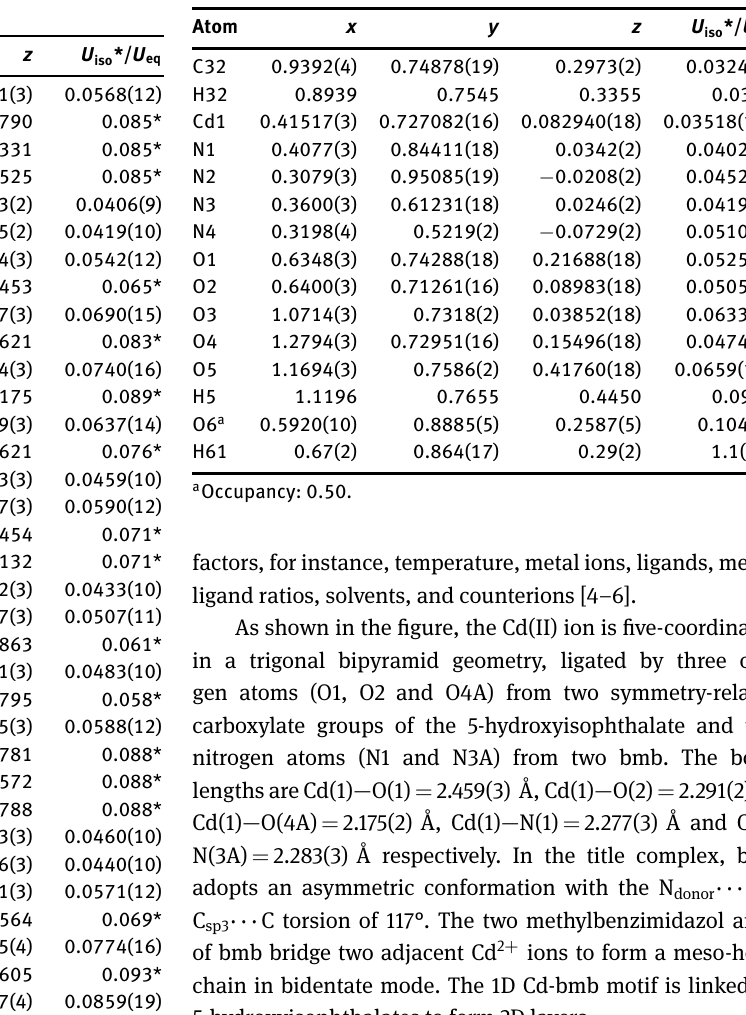
Table 2: Fractional atomic coordinates and isotropic or equivalent isotropic displacement parameters (Å 2